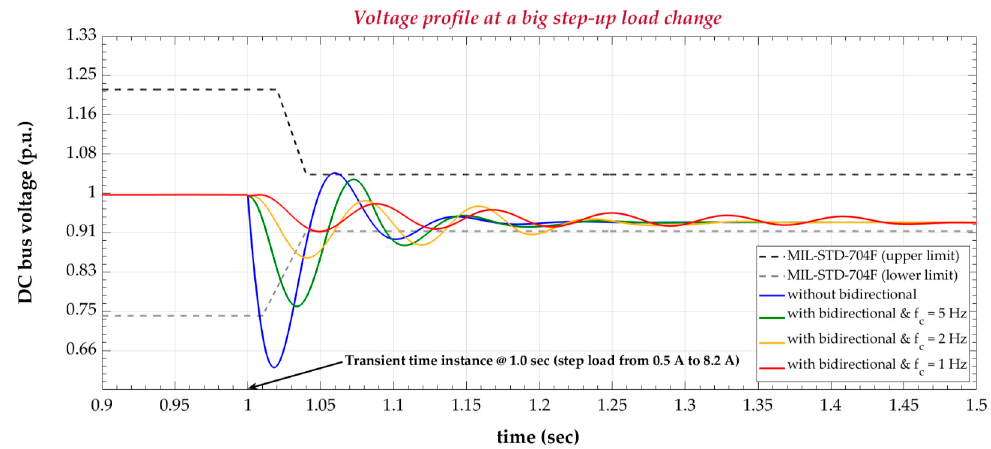
Figure 8. DC bus voltage response for a voltage sag, with the LPF cutoff frequency as a parameter.